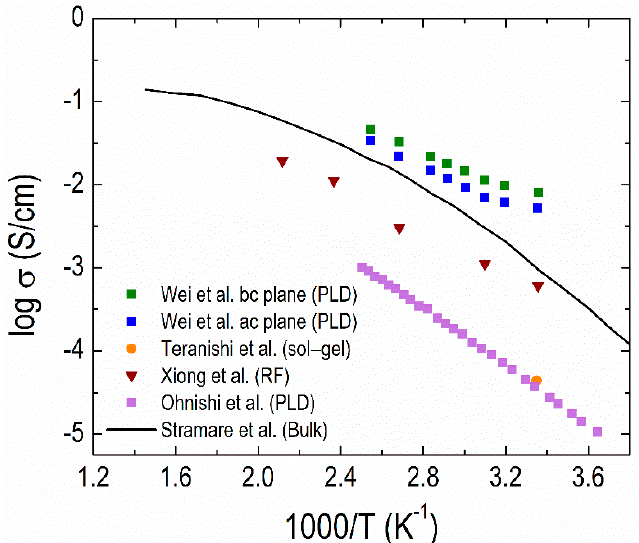
Figure 13. Conductivity summary of bulk [412] and thin-film LiPON deposited via PLD [411,412] , RF sputtering [179,409,410] and ALD [413] .